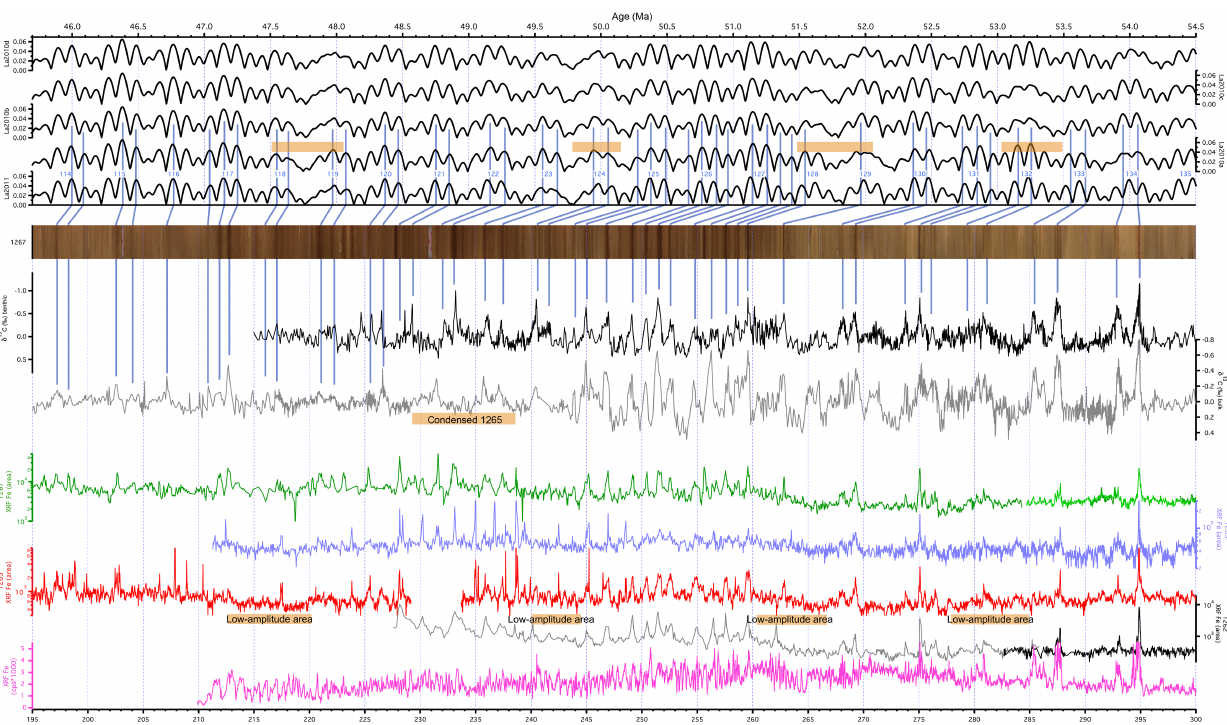
Figure 3. Correlation ties for astronomical calibration from 54.5 to 46Ma. The top panel shows the numerical solutions La2011 (Laskar et al., 2011b) and La2010a-d (Laskar et al., 2011a), including the 405kyr cycle number counted backwards from today (Wade and Pälike, 2004). Below the Site 1267 core image, which shows the best expressed dark layer pattern of all sites, we plotted the detrended benthic (black) and bulk (grey) combined δ 13 C data as well as XRF Fe intensity records on revised meters composite depth from Site 1263. Areas of low-amplitude modulation in the data are marked in the XRF data for comparison. The blue lines show the tie points for the astronomically tuned age model correlating La2010b eccentricity maxima to lighter (more negative) δ 13 C values. Note the condensed interval in the bulk Site 1265 δ 13 C data, which cannot be tuned to the orbital solutions. For detailed discussion, see the